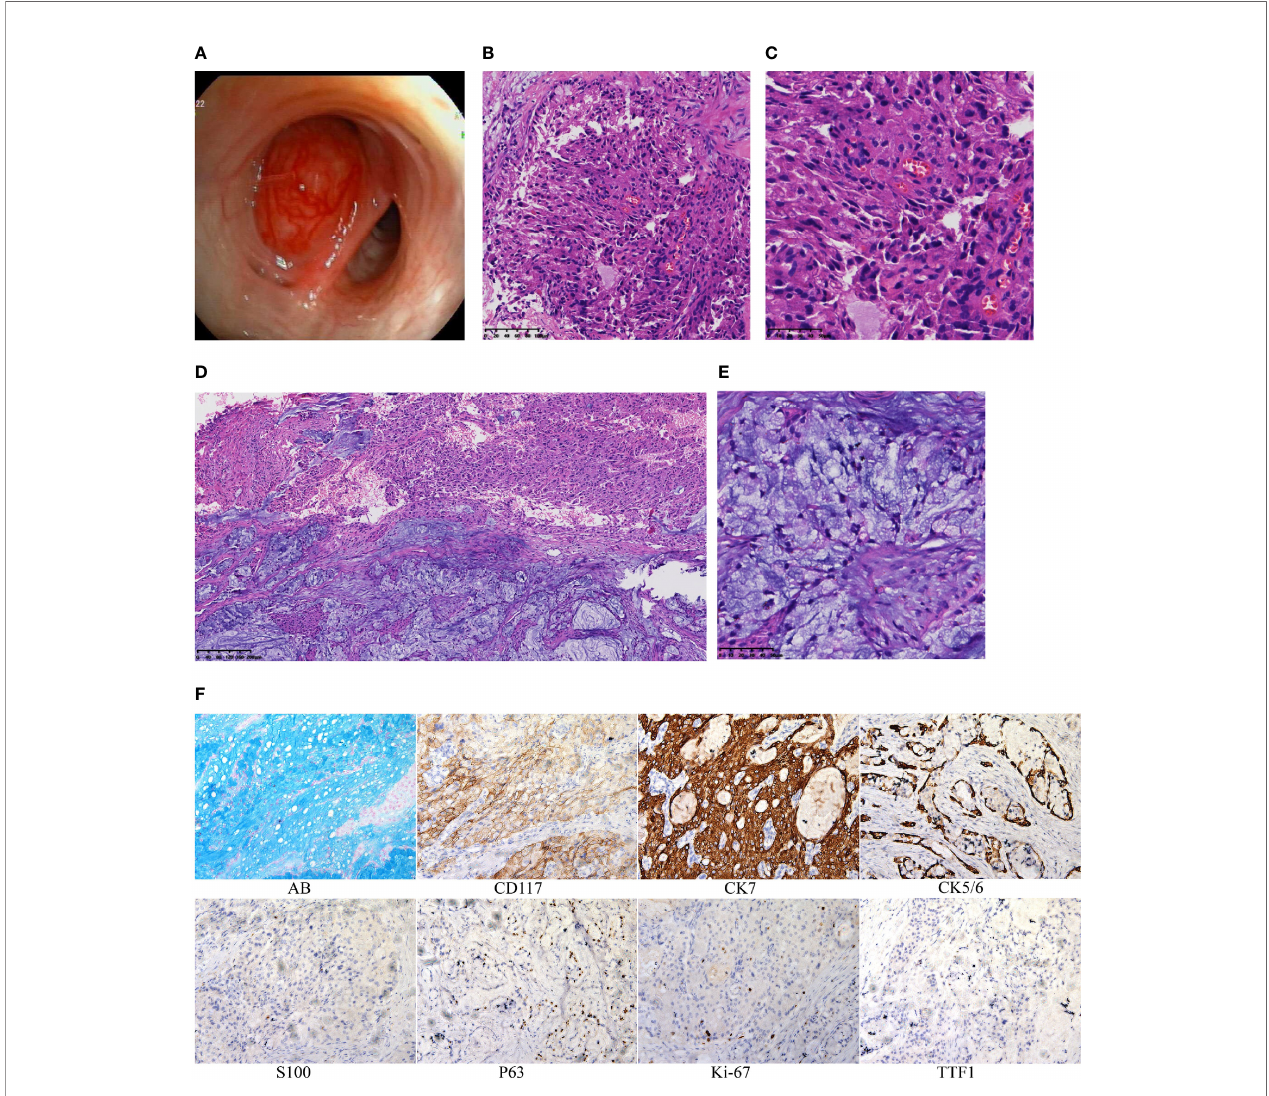
FIGURE 2 | (A) The organisms protruding in the bronchus. (B) Histologic section showing the oncocytic MEC obtained by transbronchial forceps biopsy (hematoxylin and eosin staining 20×). (C) Histologic section showing the oncocytic MEC obtained by transbronchial forceps biopsy (40×). (D) Histologic section showing the PMEC obtained by surgery (10×). (E) Histologic section showing the PMEC obtained by surgery (40×). (F) By immunohistochemistry, tumor cells are positive for AB\CD117\CK7\CK5/6\P63\Ki-67 and negative for